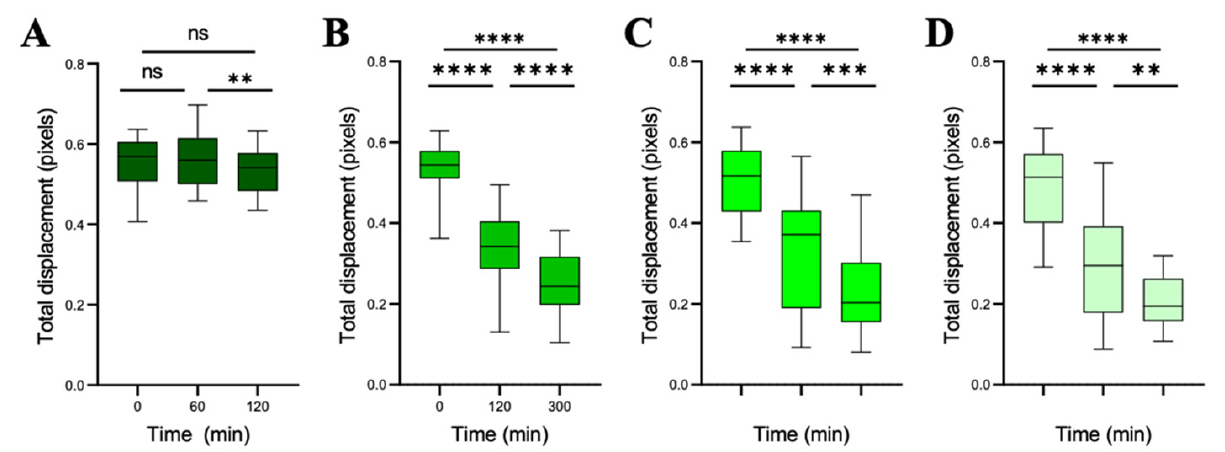
Figure 14. The average cellular nanomotion of 20 cells of C. albicans azole hypersusceptible DSY1024 strain treated with fluconazole. The total displacement of 20 cells was analysed during ( A ) 2 h of growth in a YPD medium (control) and during 5 h of fluconazole treatment at ( B ) 0.5 µg/mL, ( C ) 1 µg/mL, and ( D ) 100 µg/mL. Wilcoxon test: **** p < 0.0001; *** p < 0.001; ** p < 0.01; ns: not signi fi cant.